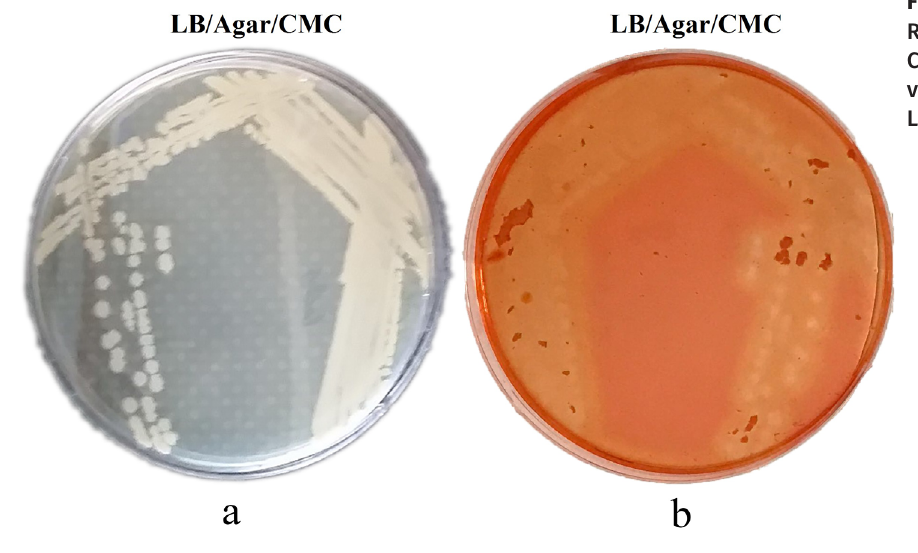
Figure 3. Bacillus subtilis RSKK246 colonies (a) and CMCase phenotypic testing via Congo red dying (b) on LB/Agar/CMC